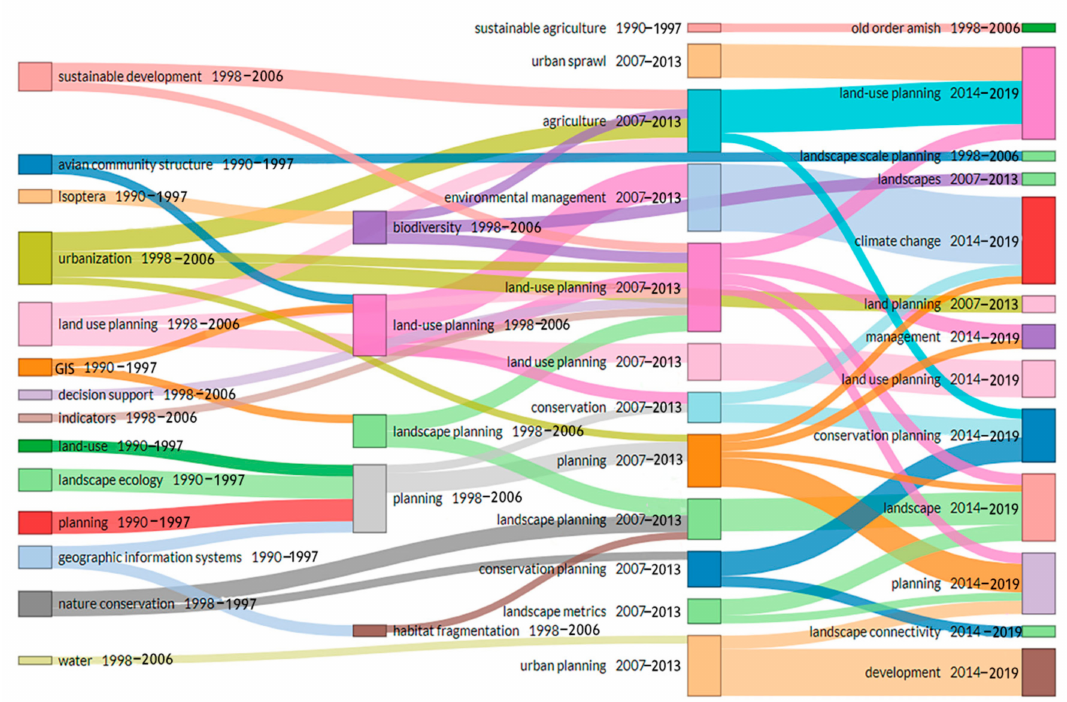
Figure 12. Thematic evolution of land use planning studies from 1990 to